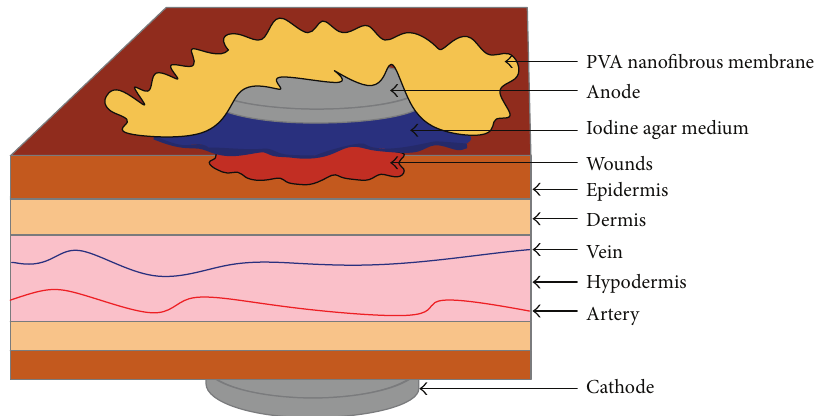
Figure 13: The schematic diagram of combining the silver iodide and silver nanoparticle PVA nanofibrous membrane.